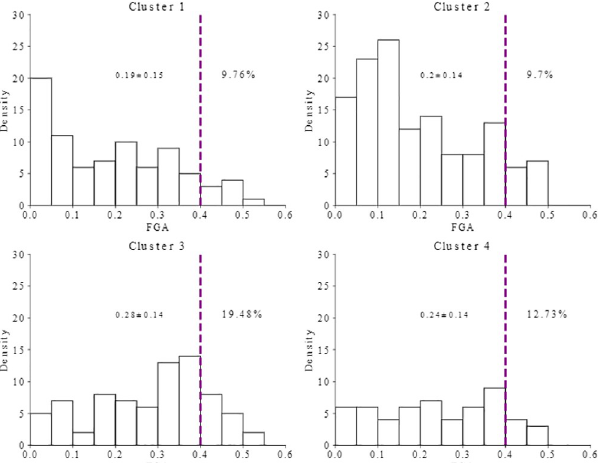
Fig 3. Distribution of FGA across four clusters of breast cancer. Dashed line represents the genes with high FGA values.